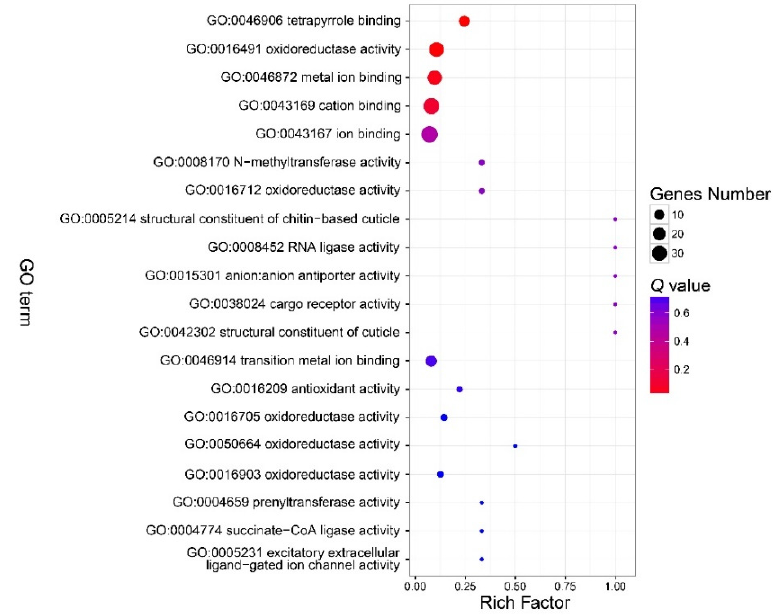
Figure 4. Bubble chart that shows the top 20 enriched GO terms in the molecular function part. There were three GO terms in the function part enriched. See note for Figure 3.